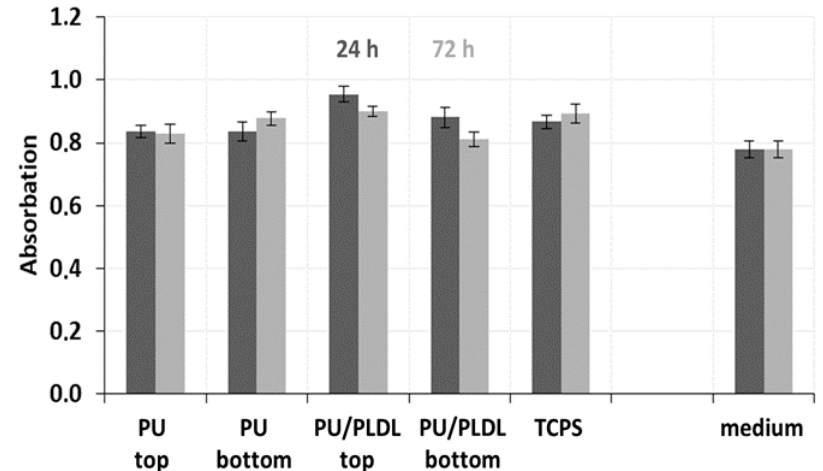
Figure 10. Values of proteins secretion by mice fibroblast NIH 3T3 separately for the first and third day of cell culture in the PU and PU/PLDL 8/2 sponges.